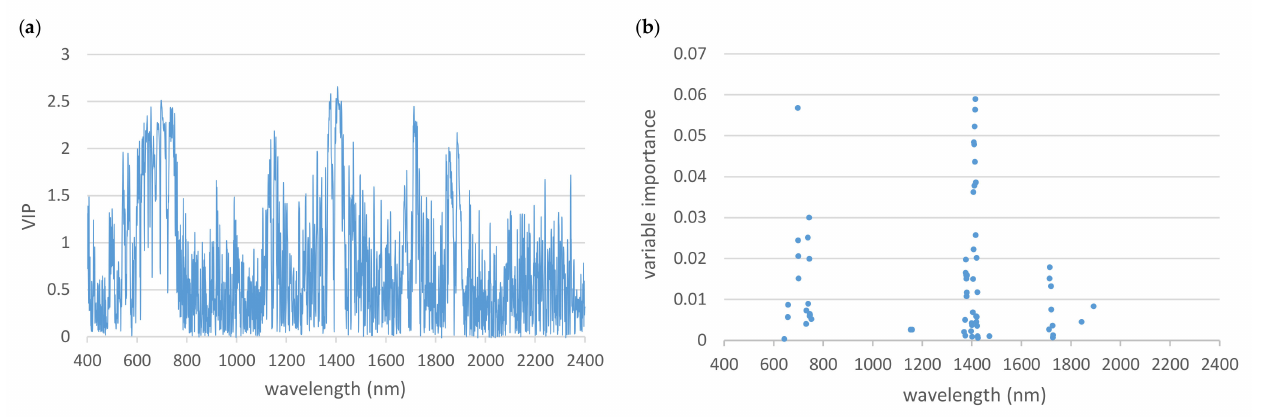
Figure 10. Variable importance for second derivative reflectance computed by PLSR ( a ), and RFR based on Spearman correlation-selected variables ( b ).